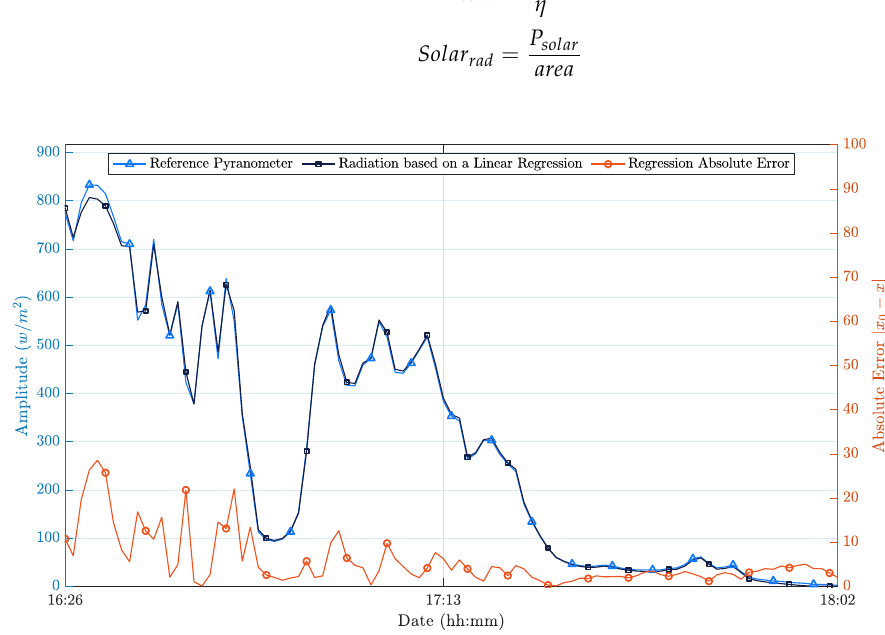
Figure 4. PV panel performance after